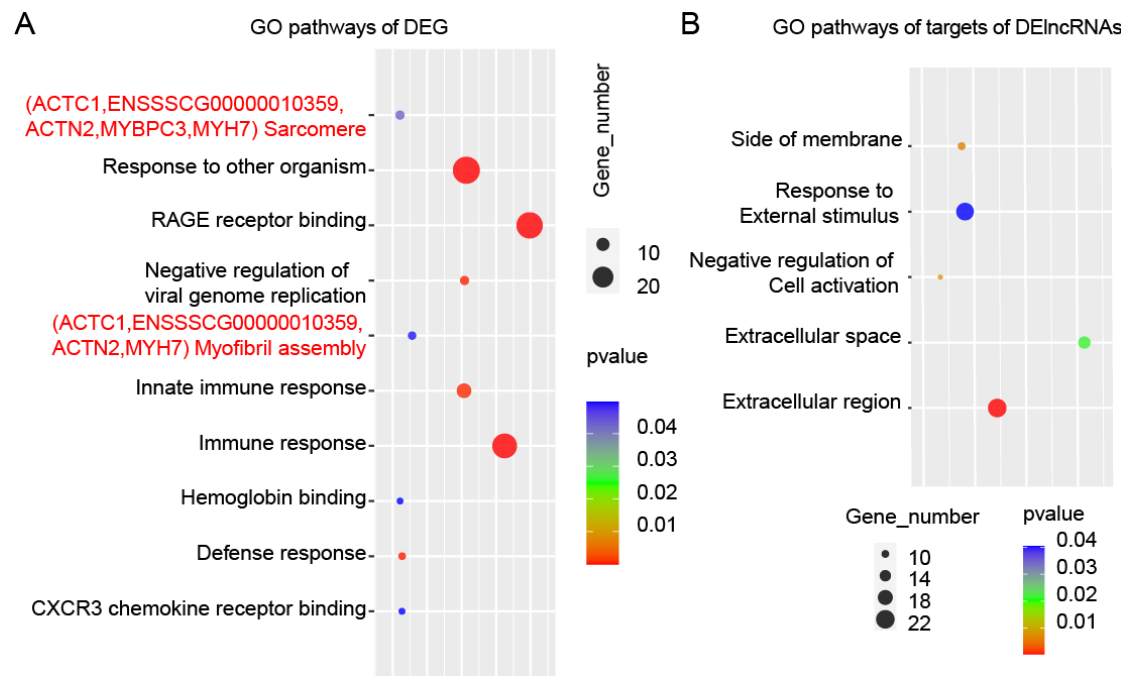
Figure 4. Enrichment analysis of DEGs and DE-lncRNAs target genes.